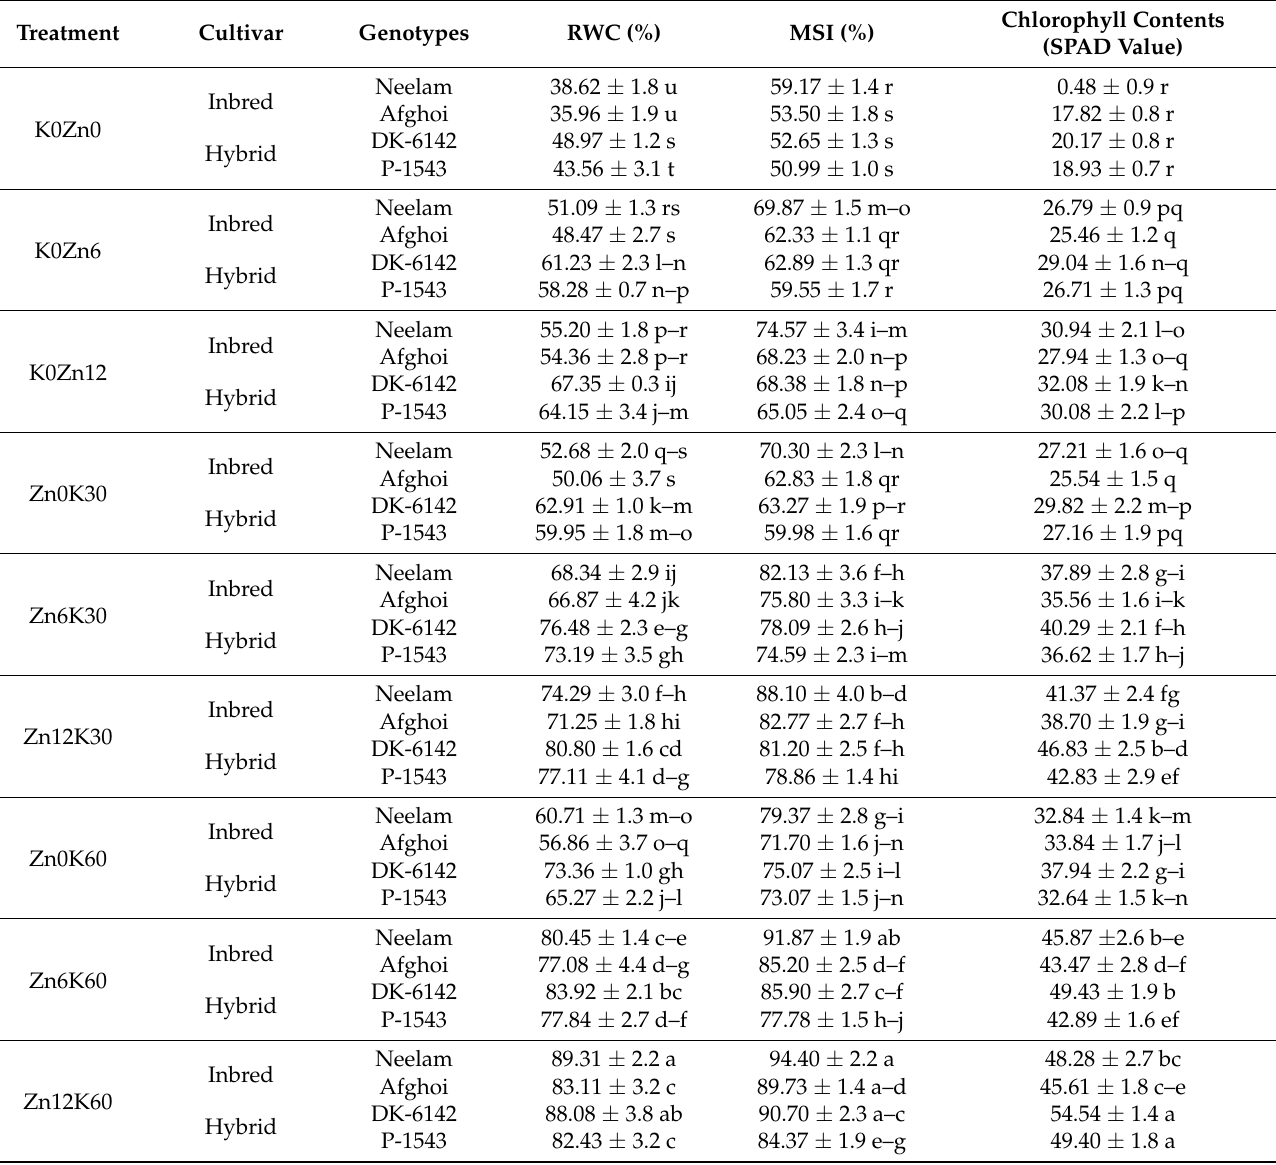
Table 2. Effect of K and Zn on physiological